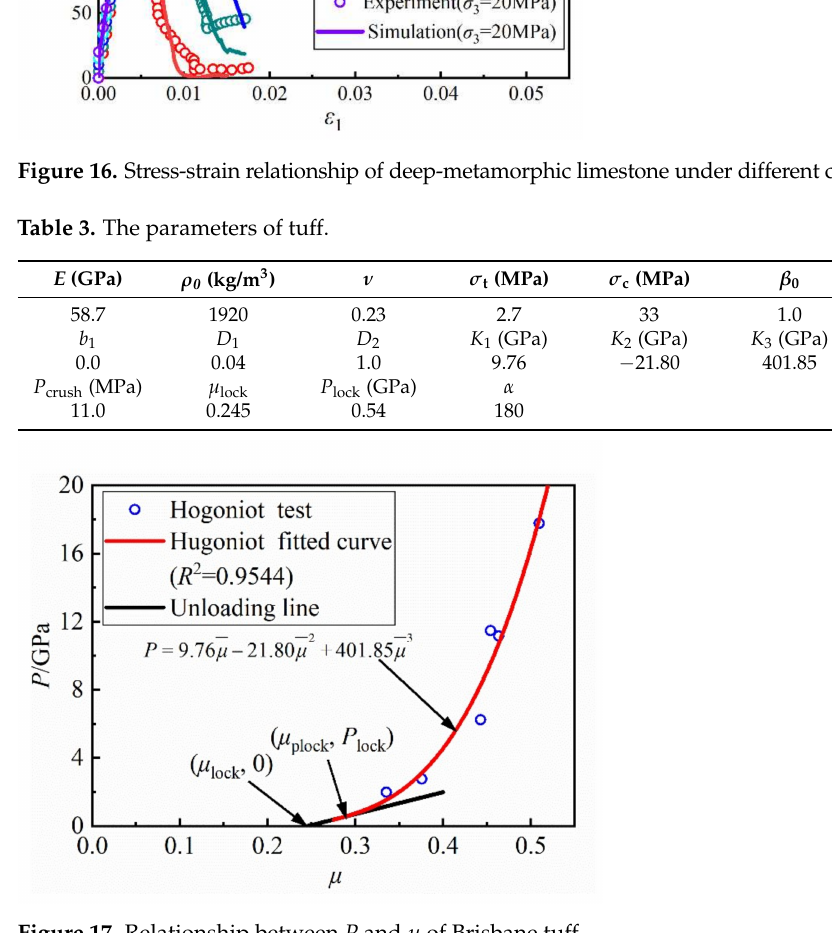
Figure 17. Relationship between P and µ of Brisbane